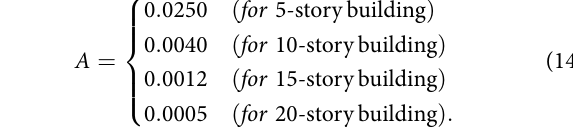
structural damping (damping ratio: 0.02) is given as the stiffness proportional damping. In 5-story building models, models 1,